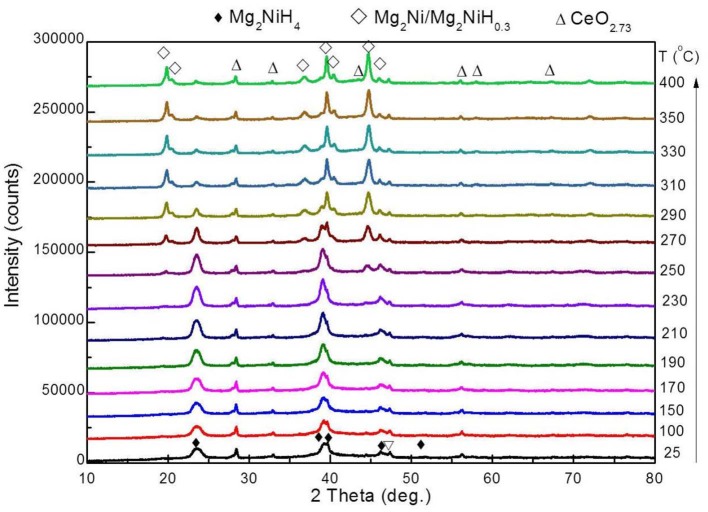
In situ XRD patterns of dehydrogenation of the ball-milled Mg2NiH4 + S5.